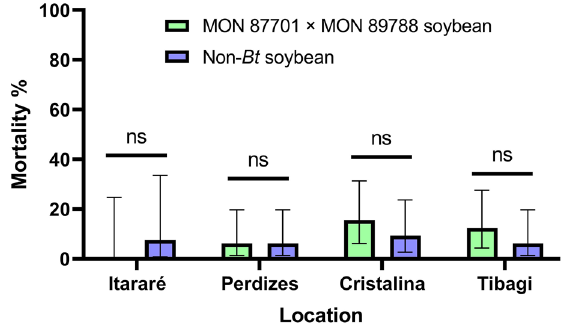
Figure 4. Percent mortality (95% CI) of C. aporema populations on MON 87701 × MON 89788 soybean and non- Bt soybean. ns =